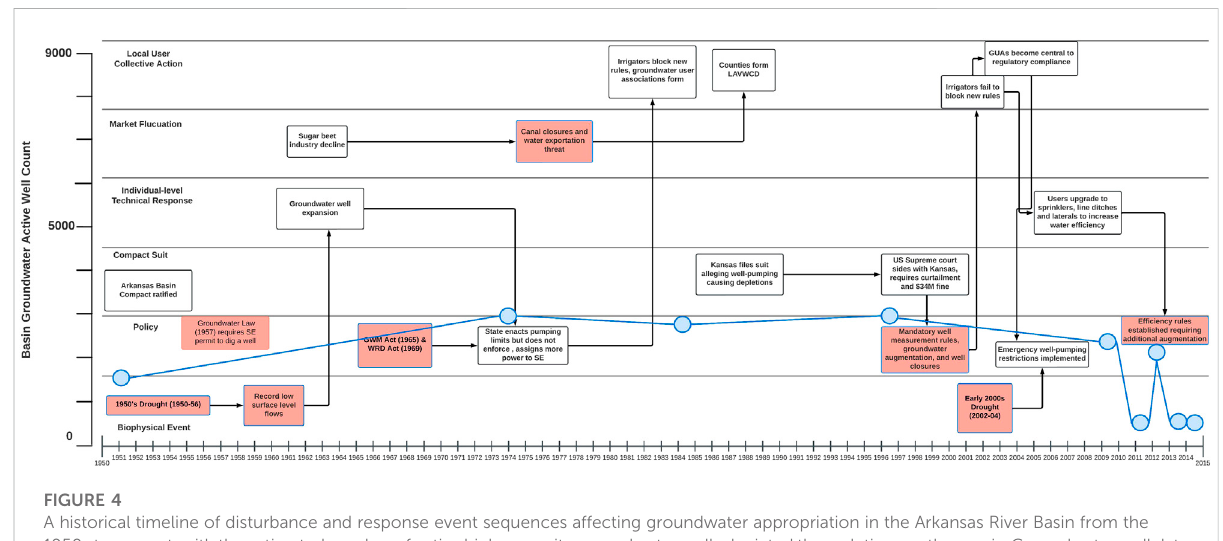
FIGURE 4 A historical timeline of disturbance and response event sequences affecting groundwater appropriation in the Arkansas River Basin from the 1950stopresent,withtheestimatednumberofactivehigh-capacitygroundwaterwellsdepictedthroughtimeonthe y -axis. Groundwater welldata is estimated based on Colorado state